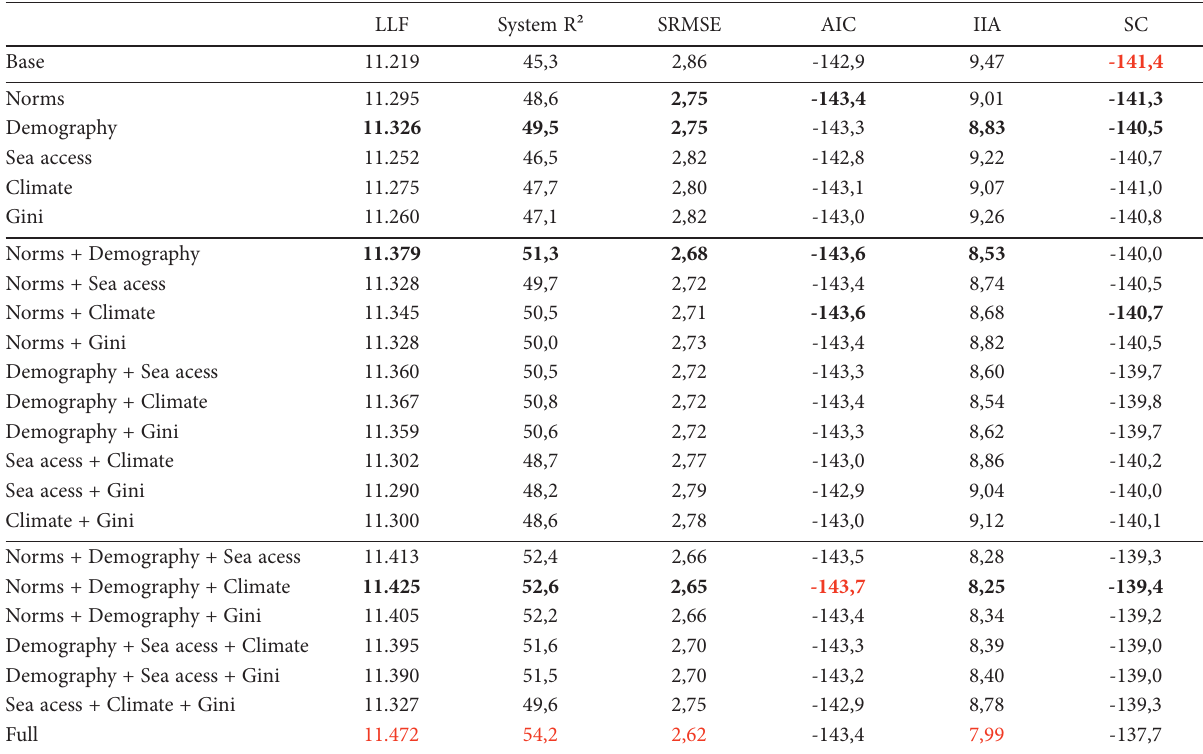
Table 5. Model selection